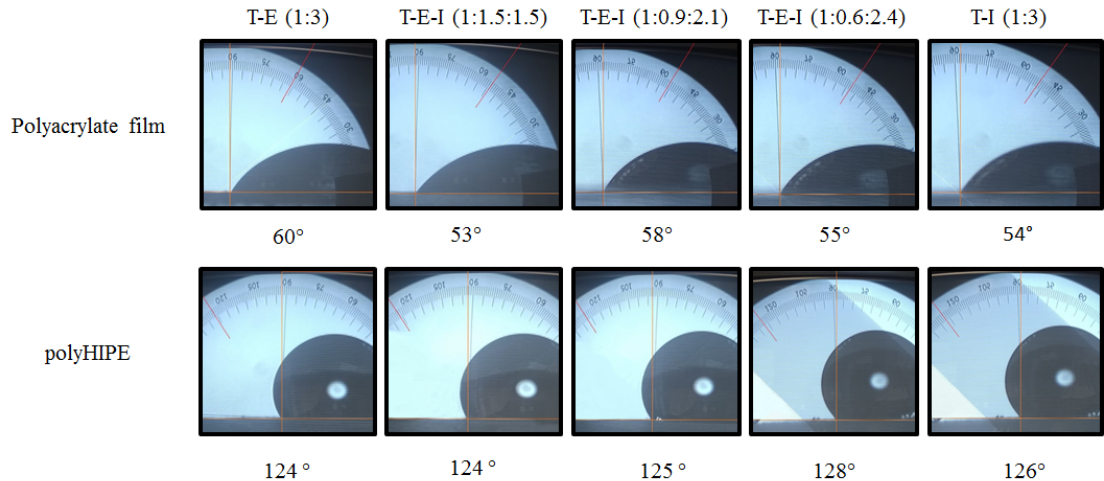
Figure 8. Comparison of Water Contact Angle (WCA) of photopolymerized films of polyacrylates derived from T–E, T–I and T–E–I and their corresponding polyHIPES.